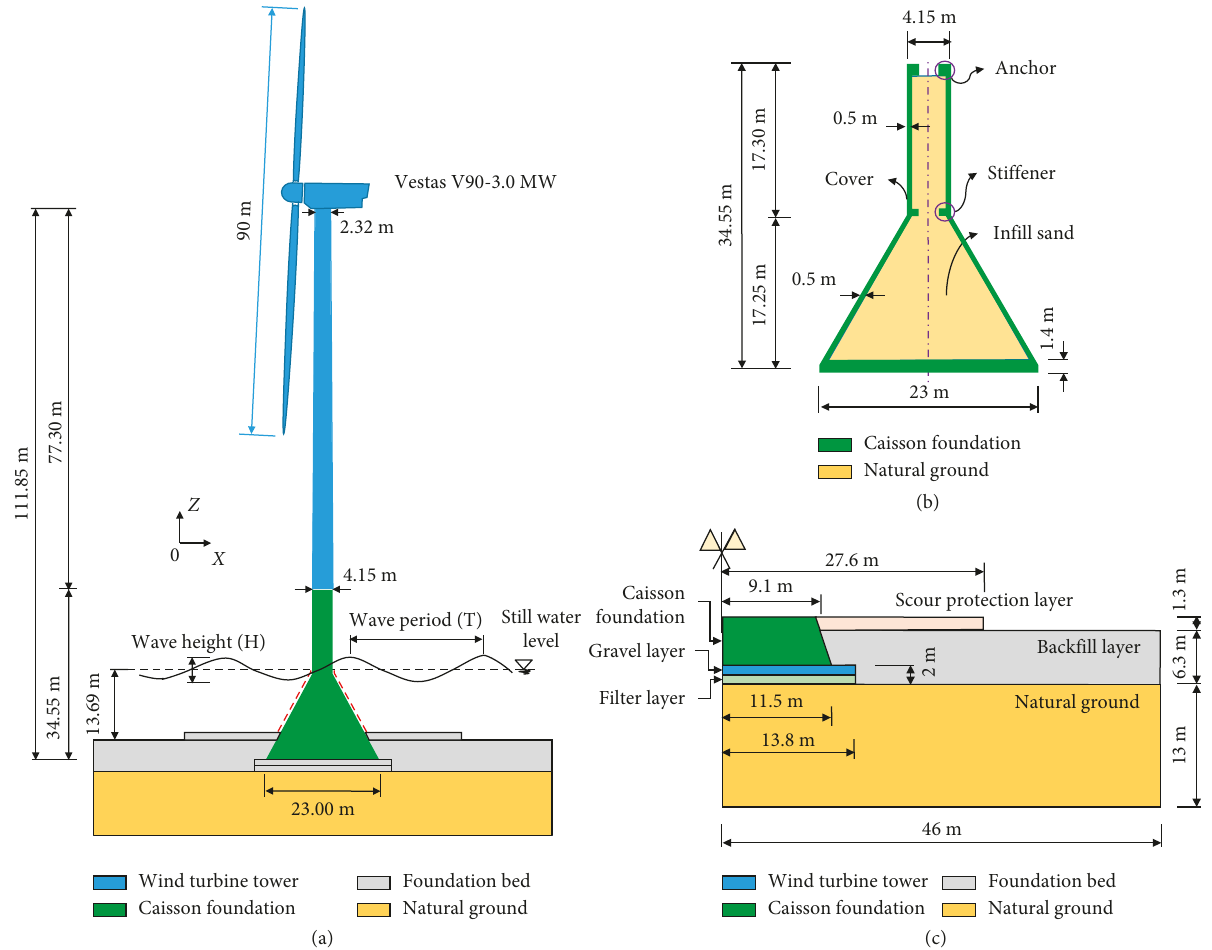
Figure 1: Geometry of target GBF WTT. (a) Lateral view of GBF WTT. (b) Caisson. (c) Foundation. Table 1: Cross-sectional thickness of the wind turbine tower [16].